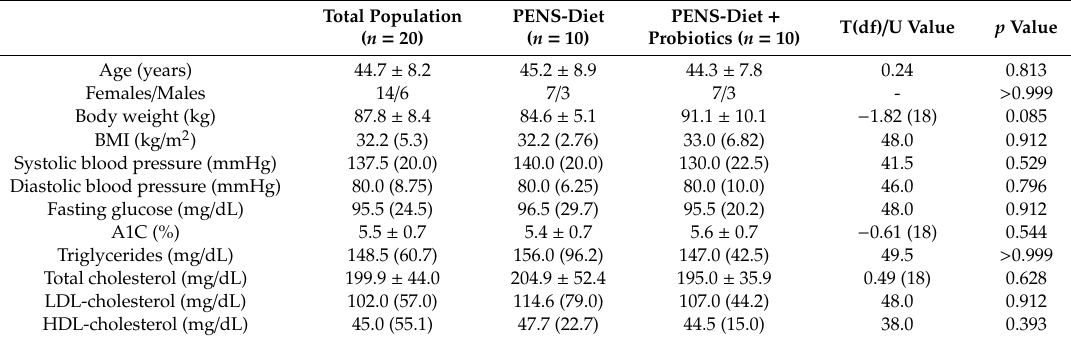
Table 1. Distribution of age, gender, and baseline blood pressure, glycemic and lipid profile between